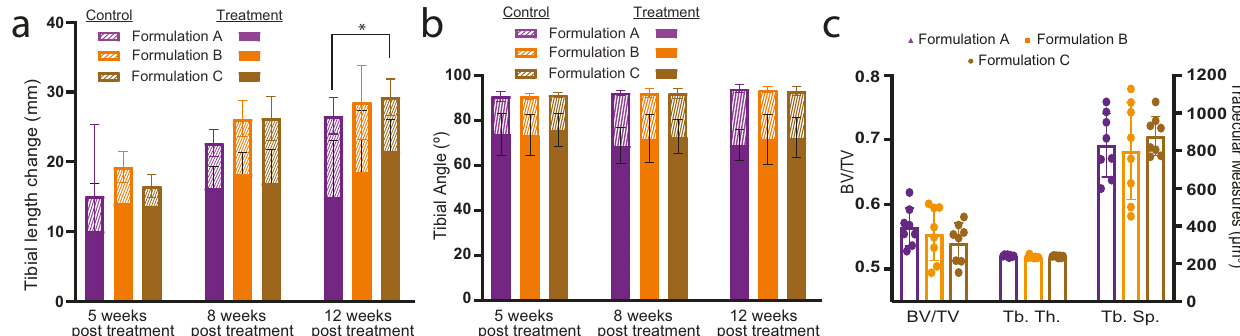
Fig. 10 Varying the structural properties of the 3D printed composite does not affect tibial length, angle, or bone metrics. a Tibial length change for the control limbs (dashed) and treatment limbs (solid bars) at 5-, 8-, and 12-weeks post treatment using Formulation A, B, or C. A signi fi cant difference was observed between Formulation A and C at 12-weeks post treatment in the treatment limb. *Denotes signi fi cant difference in tibial length change of treatment limbs (* p < 0.05; two-way ANOVA, Tukey ’ s HSD post hoc). b Tibial angle of control limbs (dashed) was similar, as were the tibial angles of the treatment limbs (solid bars) across groups at both 5-, 8-, and 12-weeks post treatment. c No bone metrics measured by microCT were different across scaffold formulations. Data represent mean ± standard deviation (error